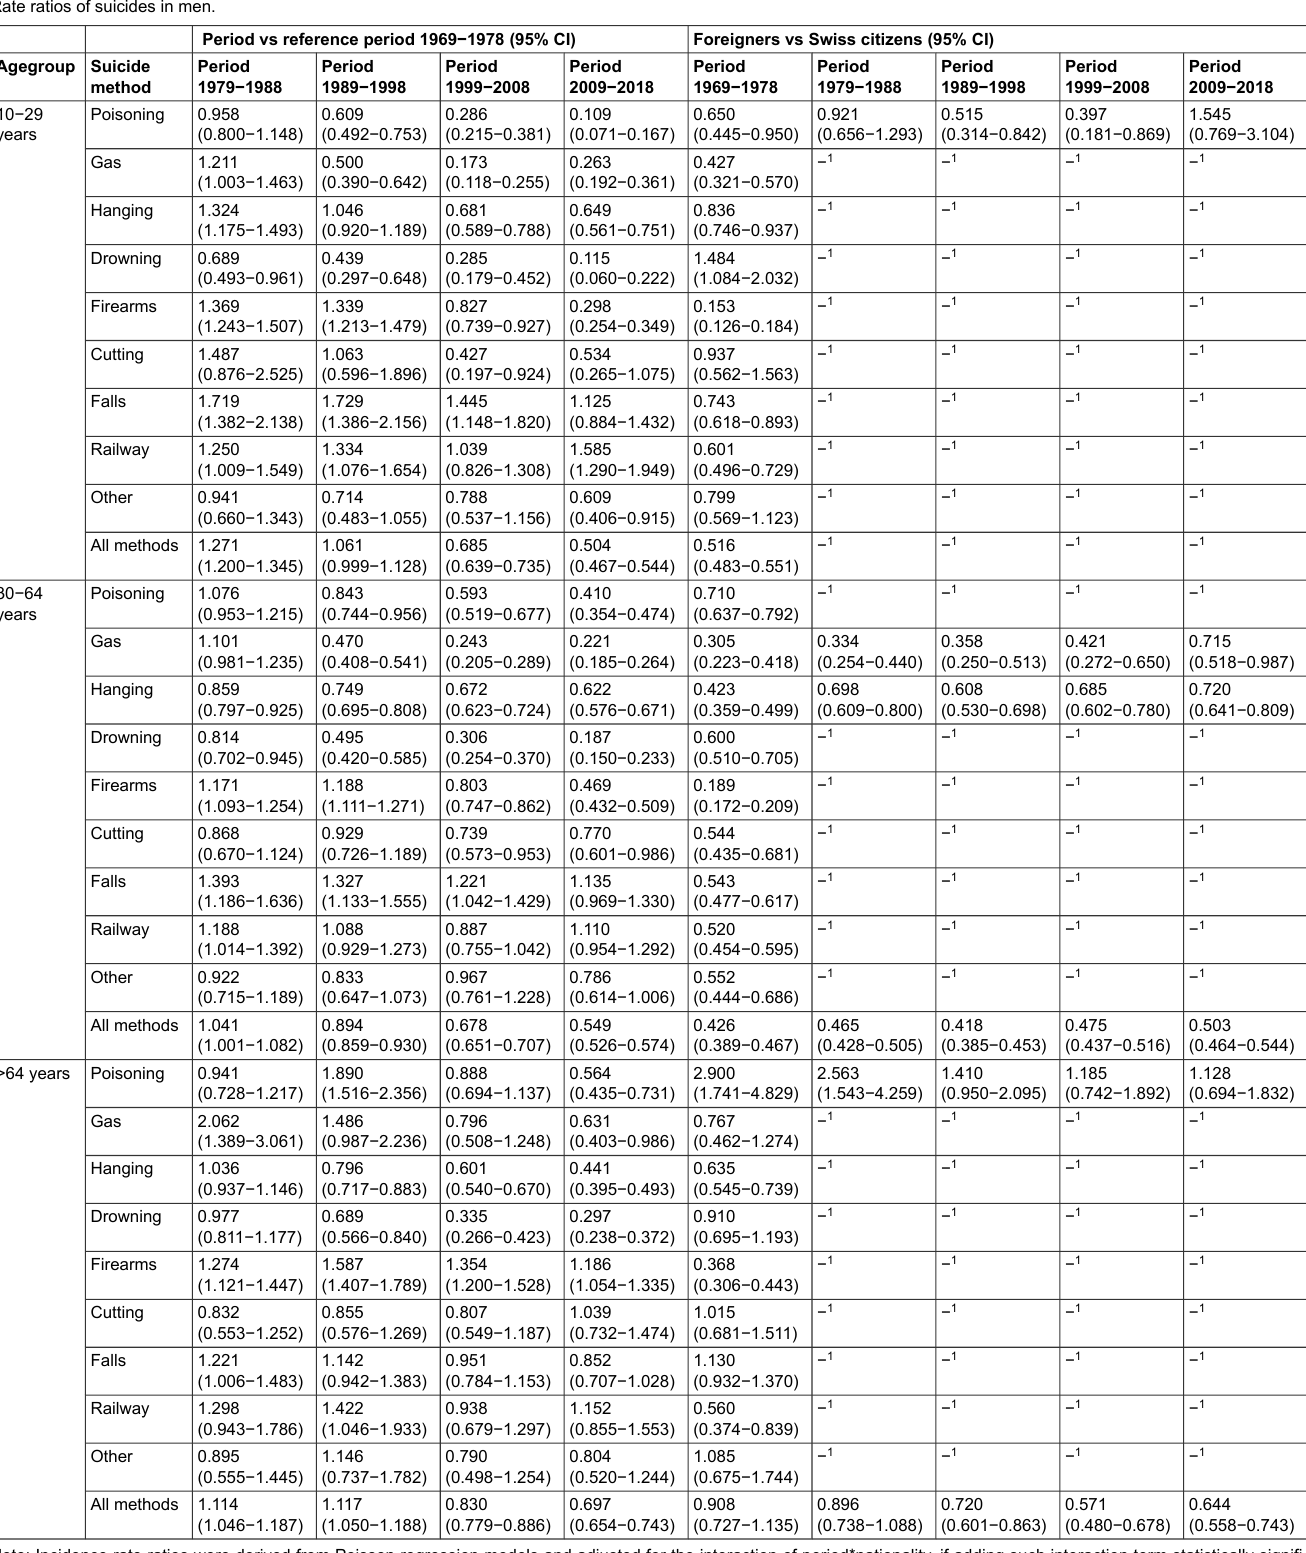
Table 3: Rate ratios of suicides in